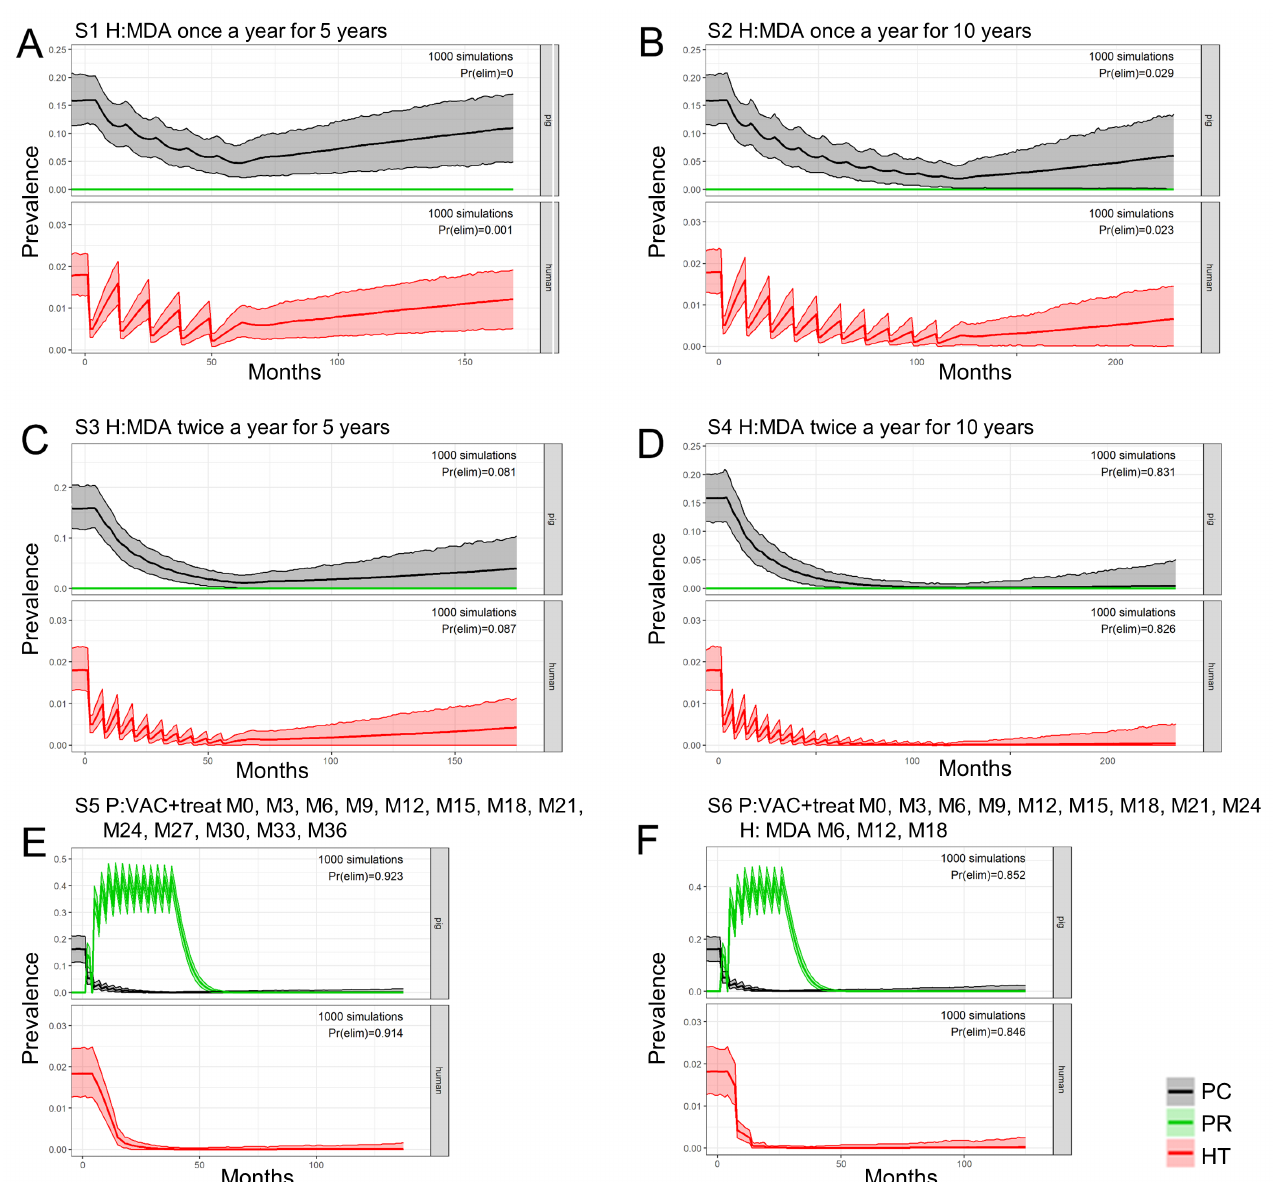
Figure 2. Simulation of various control scenarios for Taenia solium using cystiSim. The effectiveness of repeated mass drug administration (MDA) in humans (H) for taeniasis is compared with three-monthly interventions in pigs (P) involving vaccination and treatment, or a combination of pig interventions with strategic MDA in the human population after 1000 simulations (S). The impacts are shown on porcine cysticercosis (PC), immunity to T. solium infection in the pig population (PR), and human taeniasis (HT), with prevalence shown here as a proportion. The colored areas delineate the 95% uncertainty intervals for prevalence (proportion). Pr(elim) indicates the predicted probability of elimination of transmission (EOT) in the given scenario. Four scenarios are simulated which involve: MDA only in humans ( A – D ): annual treatments for 5 or 10 consecutive years ( A and B , respectively), and biannual MDA for 5 or 10 consecutive years ( C and D , respectively). Two scenarios involve pig-focussed interventions. Each included three-monthly vaccination and oxfendazole treatment of the pig population. The first involves: vaccination and treatment in pigs ( E ) for 3 years. The second ( F ) also involves pig interventions, but includes three human MDA rounds, at 6, 12, and 18 months after the initiation of the interventions in pigs, over a total period of 2 years. This figure has been reproduced with permission from Braae et al. 42